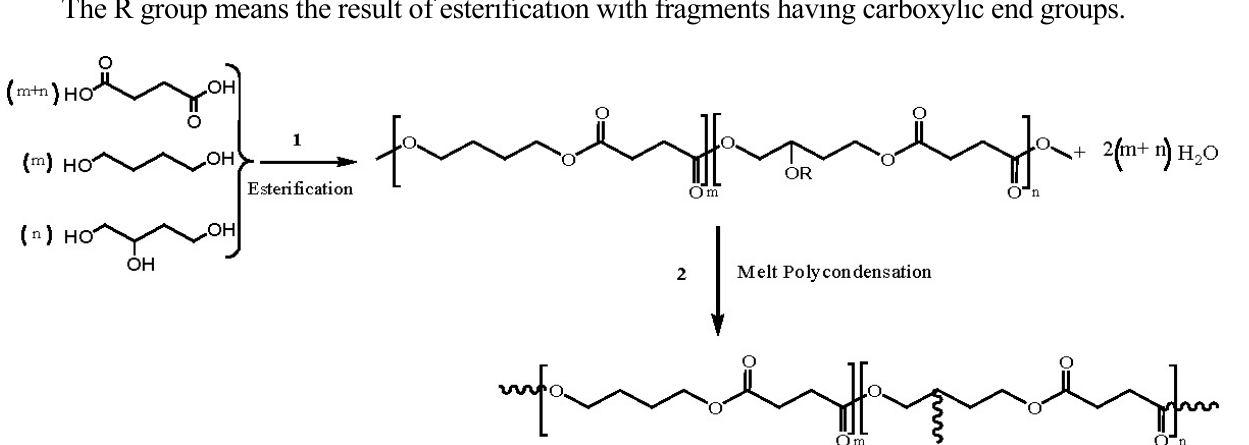
Figure 3. Synthesis of long-chain branched poly(butylene succinate) (PBS), based on [72]. The R group means the result of esterification with fragments having carboxylic end